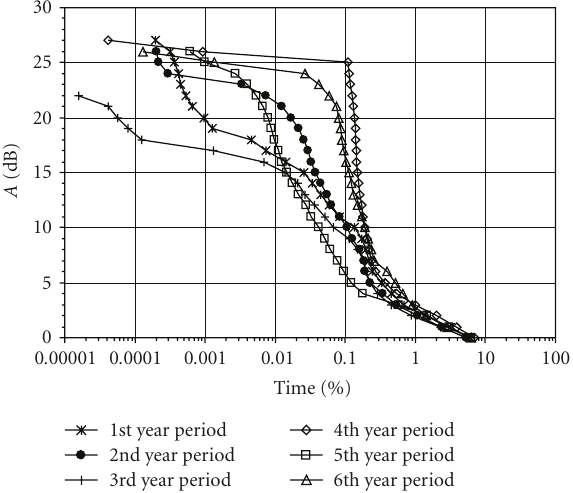
Figure 7: Obtained CDs of attenuation due to fog events on the FSO path over the 6-year period of